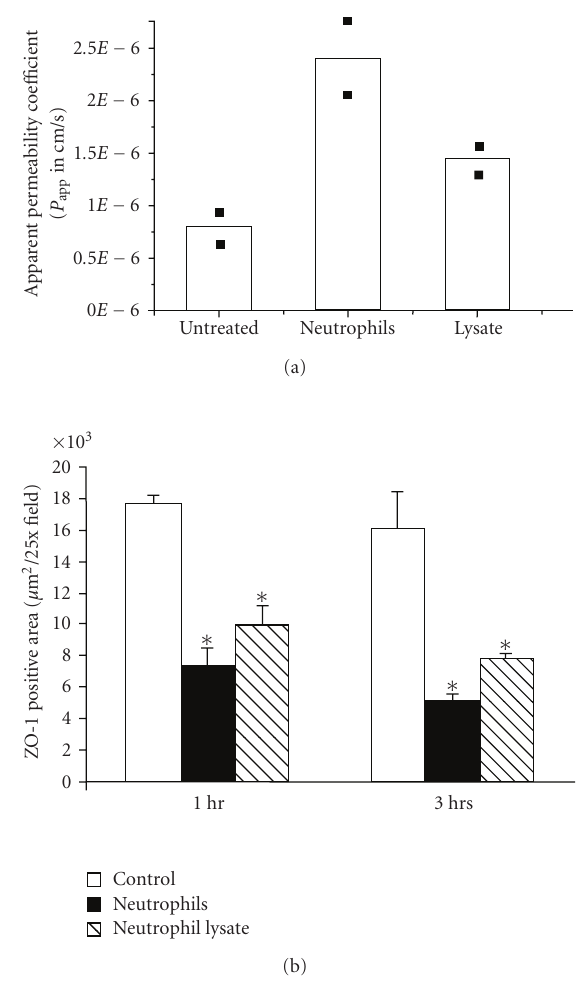
Figure 4: Neutrophil and neutrophil lysate exposure increased the explant permeability (a) and decreased ZO-1 (b) expression. In (a), the basolateral side of the explant was incubated with neutrophils or neutrophil lysate for 3 hours at 37 ◦ C. The apparent permeability was determined by [ 3 H]-mannitol flux. Increased permeability induced by neutrophils or neutrophil lysate is seen compared with control (two separate experiments); the variations between experiments were less than 10%. In (b), the disruption of tight junction protein ZO-1 by neutrophils or neutrophil lysate in the RPE monolayer was compared by confocal immunofluorescent staining in 3 separate experiments. Quantitation of ZO-1 staining positive area was determined by LSM 510 image software. Both neutrophil and neutrophil lysate decreased the expression of ZO-1 expression. ∗ P < .